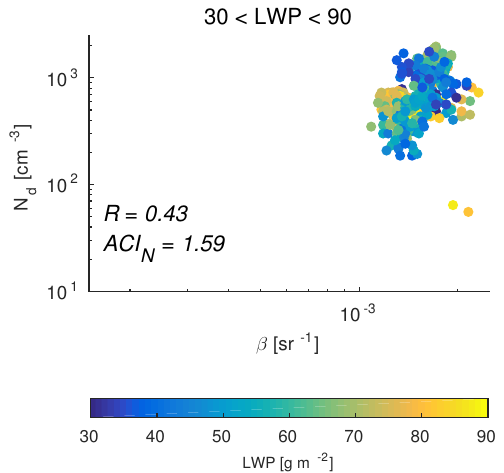
Figure 8. The cloud droplet number concentration, N d , derived from WACR and MWR measurements with Eq. (11) is plotted ver- sus the integrated attenuated backscatter ATB measured by Vaisala CT25K on 29 November 2009. The corresponding value of ACI N (Eq. 7) and the Pearson product-moment correlation coefficient, R , is presented.